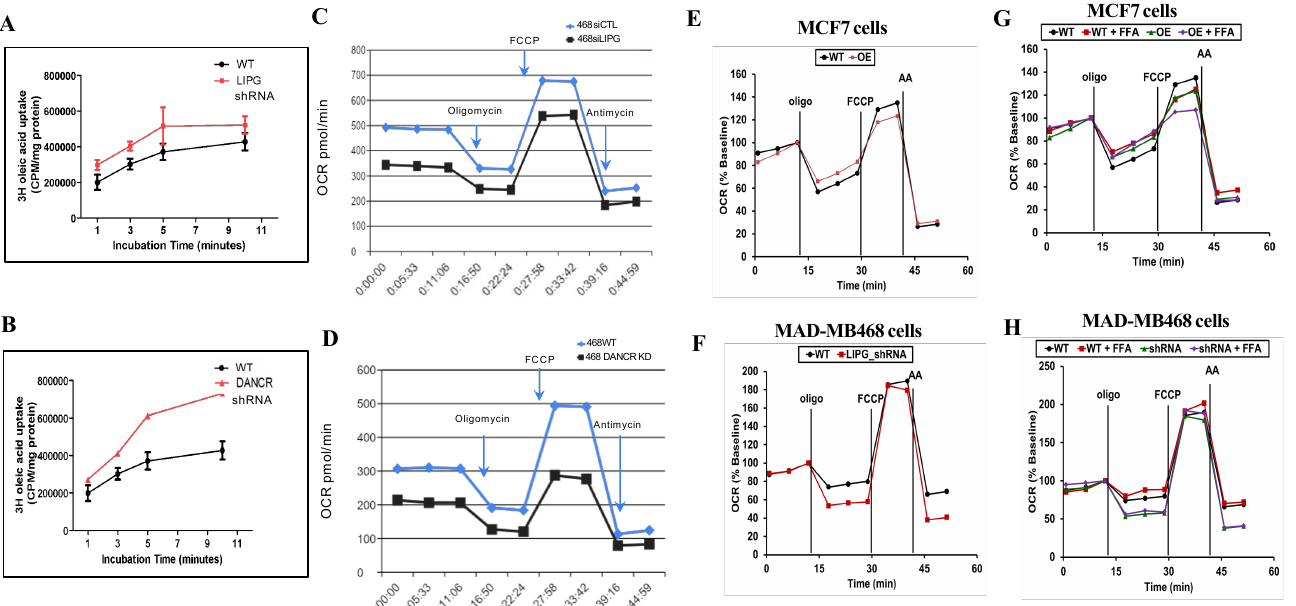
Figure 2. LIPG knockdown inhibits OCR. ( A , B ) Oleic acid uptake assay in MDA-MB-468 cells (WT), and LIPG or DANCR shRNA stable MDA-MB-468 cells. ( C , D ) Seahorse analysis of